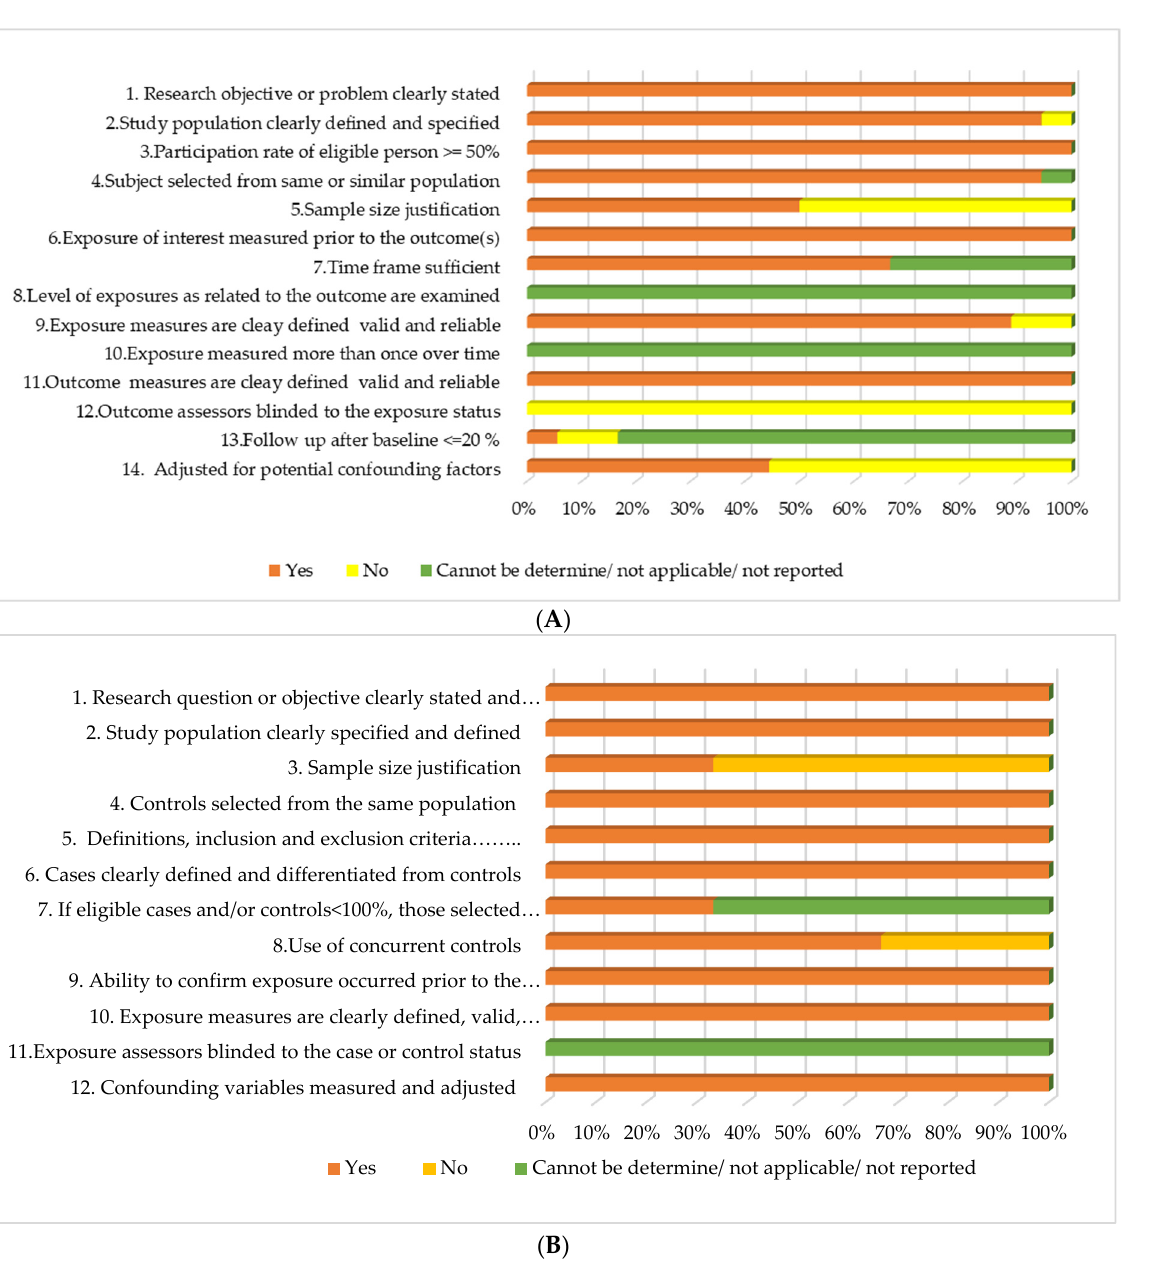
Figure 2 . ( A ) Quality assessment of included cohort studies; ( B ) Quality assessment of included case–control studies.